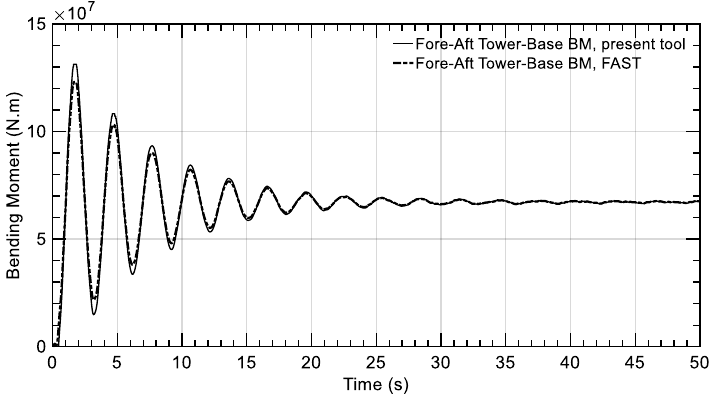
Figure 14. Tower-base, fore-aft bending moment.